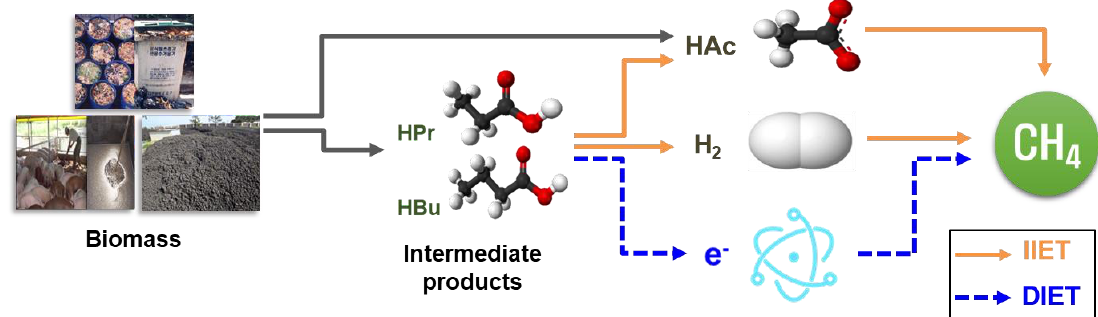
Figure 1. Indirect interspecies electron transfer (IIET) using acetate (HAc) and / or hydrogen (H 2 ) vs. direct interspecies electron transfer (DIET) in anaerobic digestion.